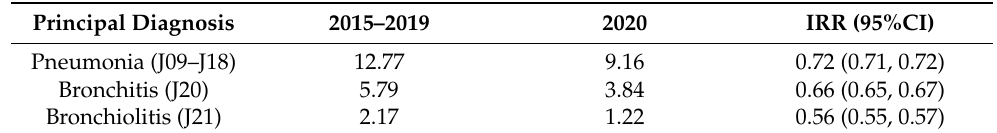
Table 3. Incidence per 1000 person-years during the COVID-19 pandemic (2020) compared to the previous five years (2015–2019).